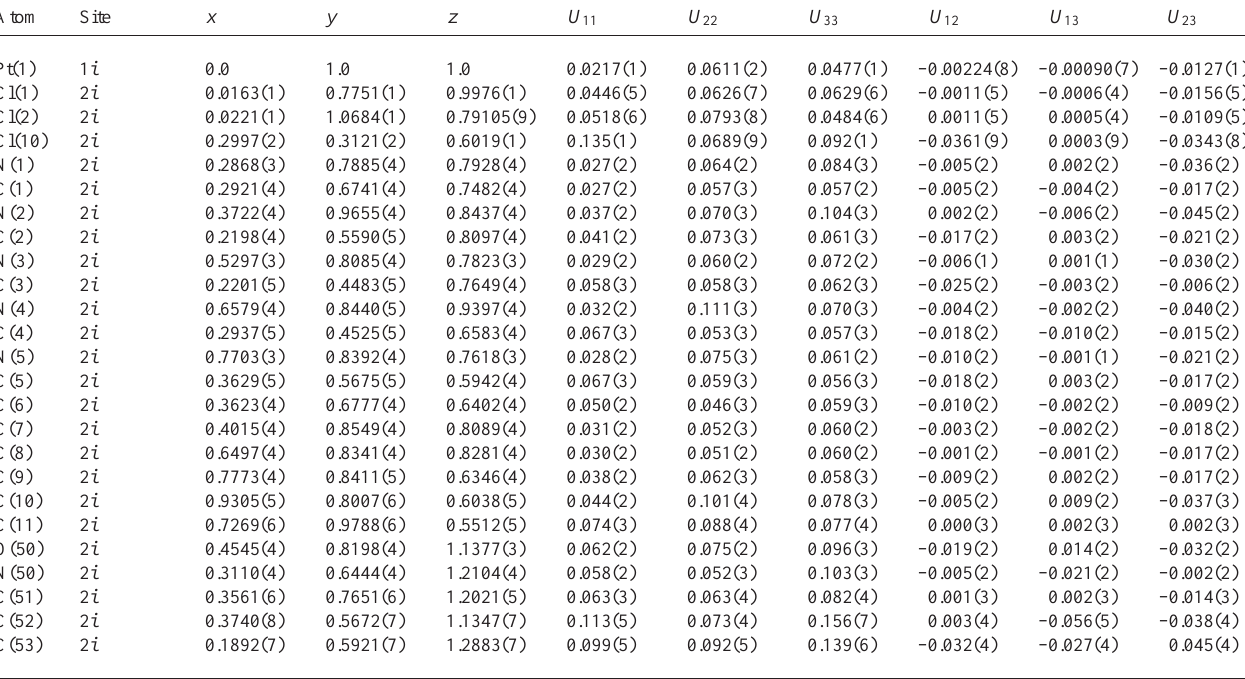
Table 3. Atomic coordinates and displacement parameters (in Å 2 ) .